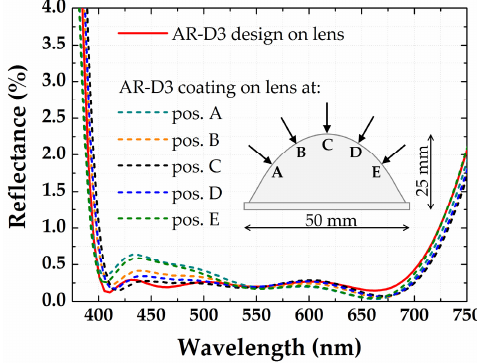
Figure 8. Measured and expected reflectance spectra (AOI = 0 ◦ ) of the AR-coated steeply curved B270 aspherical lens at different positions of the lens.